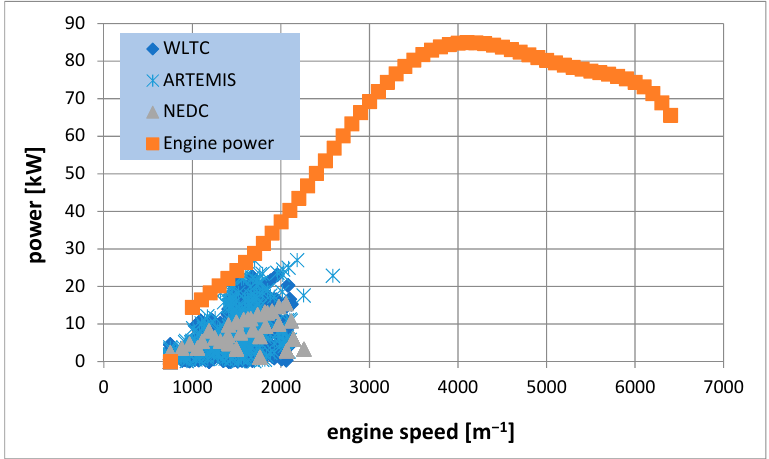
Figure 2. The required road load power versus engine speed for phases of ARTEMIS, WLTC and NDEC driving cycles corresponding to urban traffic